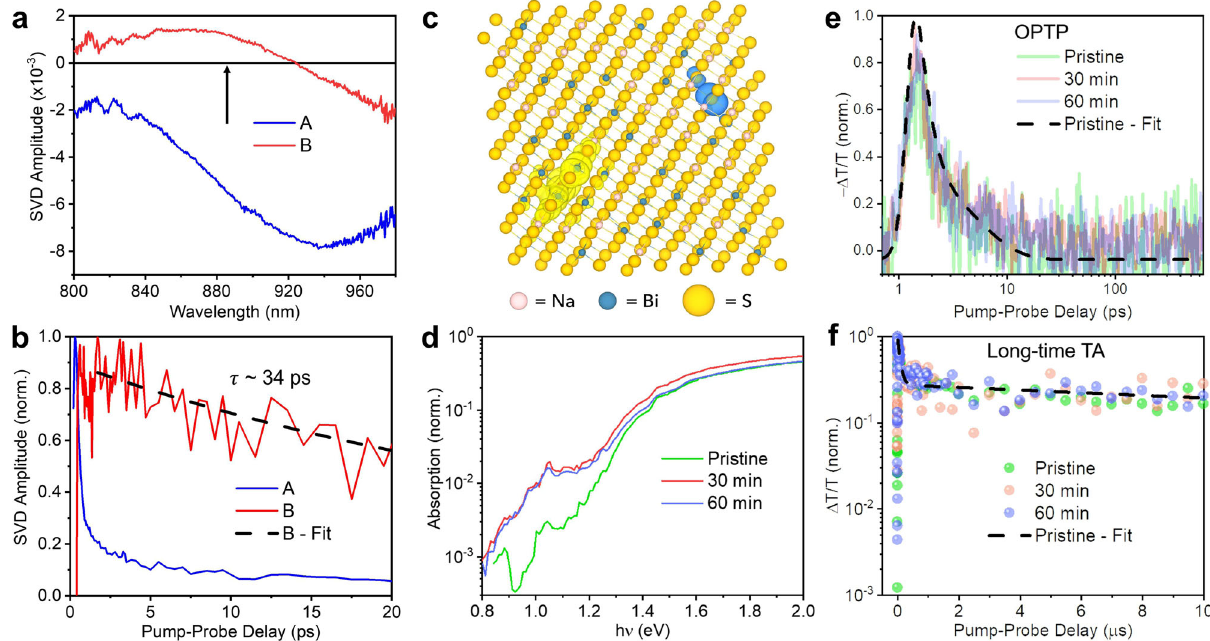
Fig. 4 | Physical mechanism behind the unusual charge-carrier kinetics in NaBiS 2 . a Amplitude of the two principal components (A – blue, and B – red) extractedfromthesingular-valuedecomposition(SVD)analysisoftheshort-timeTA spectrum. Black arrow indicates the wavelength corresponding to the optical bandgap of NaBiS 2 . b Normalised kinetics of the two principal SVD components (colour legend same as in a ), along with a monoexponential fi t to component B (black dashed line). c Charge density isosurfacesof a relaxed electron-hole pair in a disordered NaBiS 2 supercellwith sodium, bismuth, and sulphuratoms inpink, blue andyellowrespectively.Thetranslucentyellowandbluesurfacesrepresentelectron and hole densities, respectively. d Normalised absorption spectra of pristine and